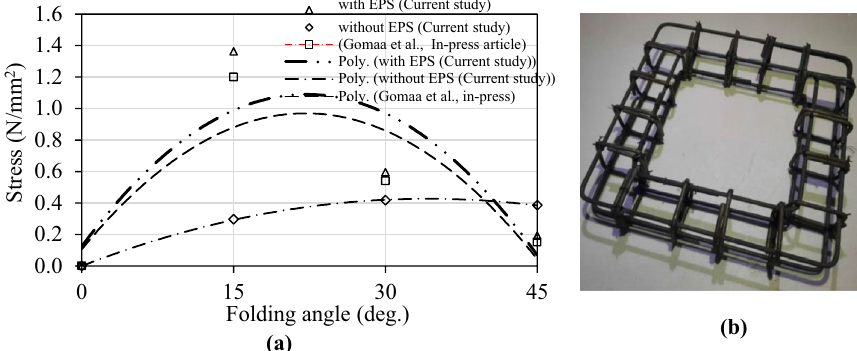
Fig. 16 Hidden ring beam ( a ) relation between folding angle and tensile stress, and ( b ) steel